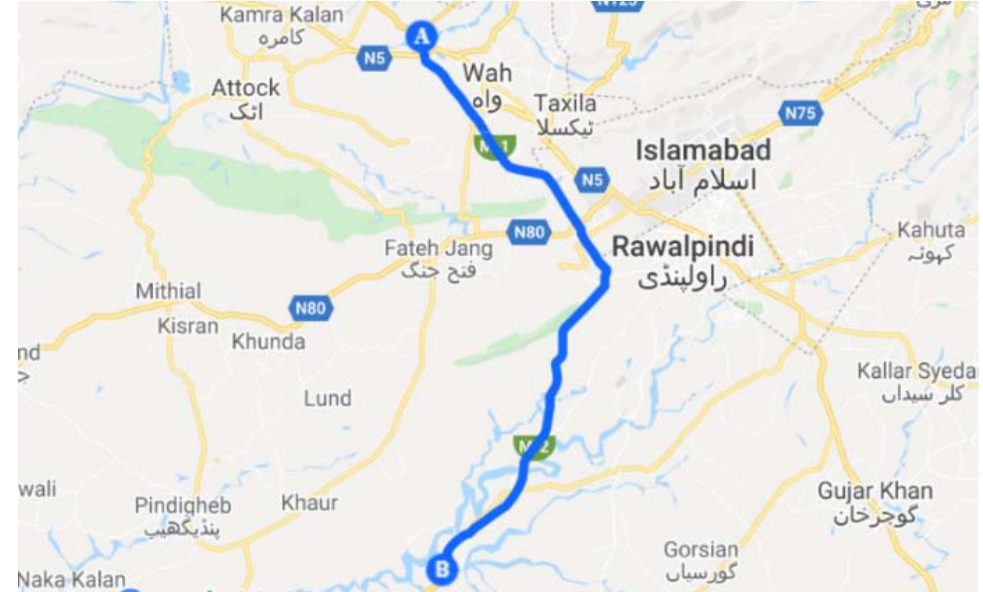
Figure 1. Study area (from Google